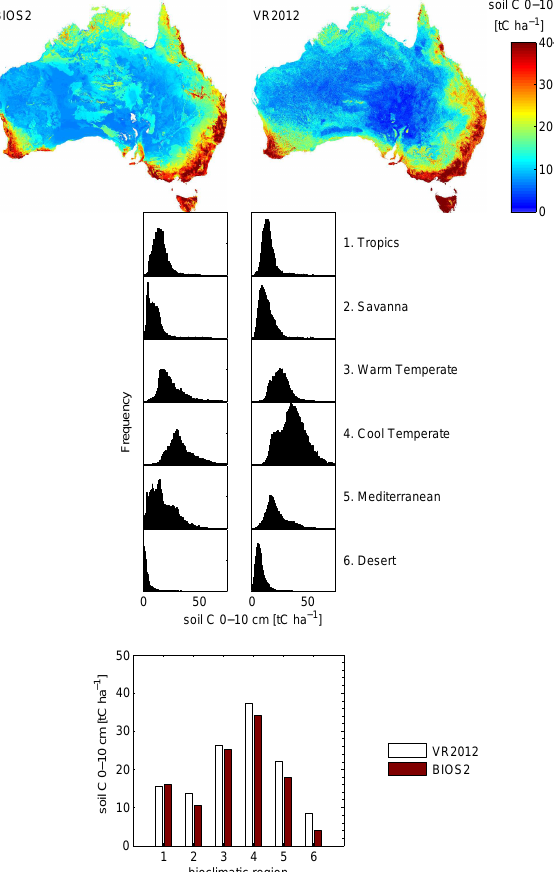
Fig. 10. Comparison of spatial distribution of soil carbon in the top 10cm from BIOS2 and VR2012. The frequency histograms for each bioclimatic region are constructed from the mapped values. The bar- plot compares the BIOS2 and VR2012 means for each region.